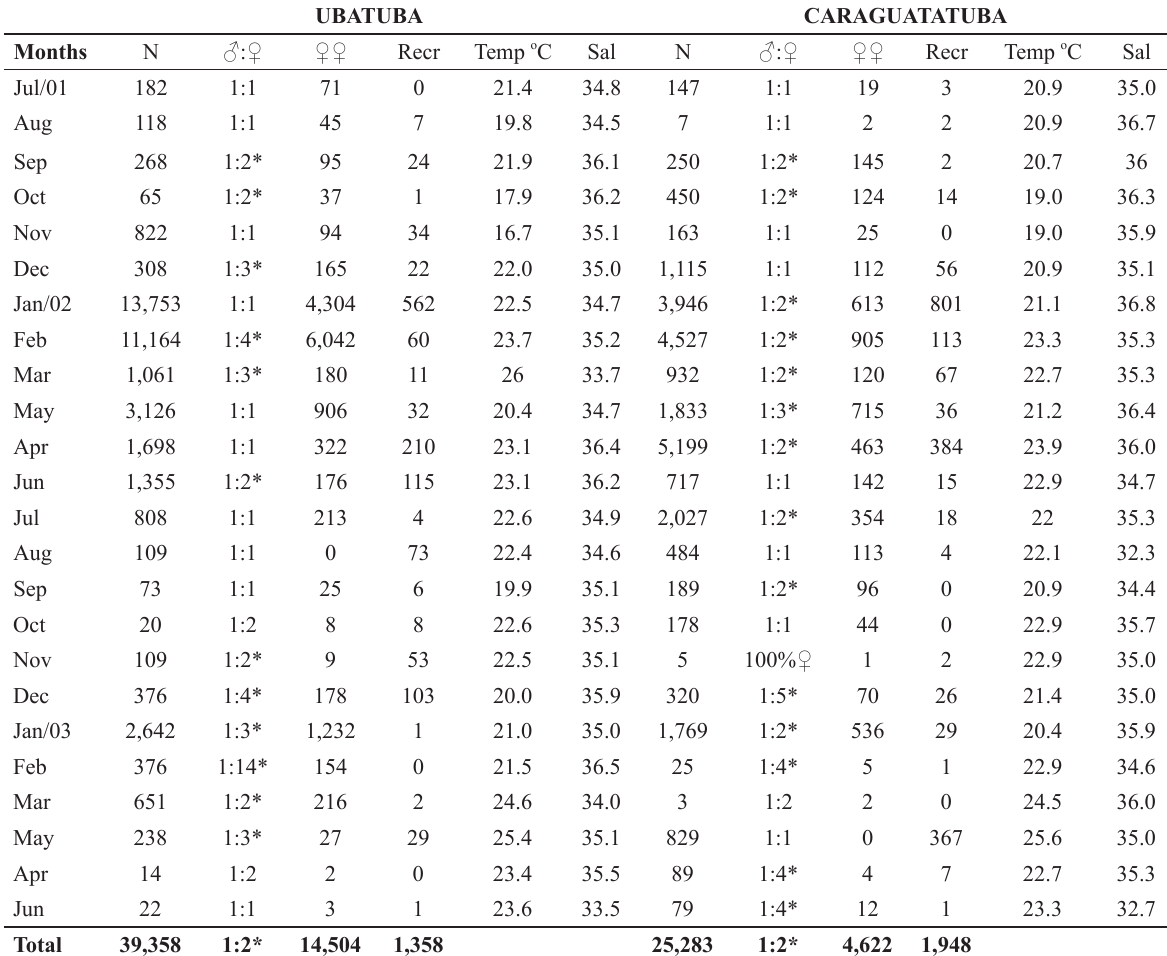
Abundance, sex ratio, number of reproductive females and recruits (Recr.), and mean bottom temperature and salinity collected monthly in each region during July 2001 to June 2003. ♂:♀ = sex ratio; * = significant difference according to χ 2 test (p < 0.05); ♀♀ = reproductive females; Recr = recruits, Temp ( o C) =